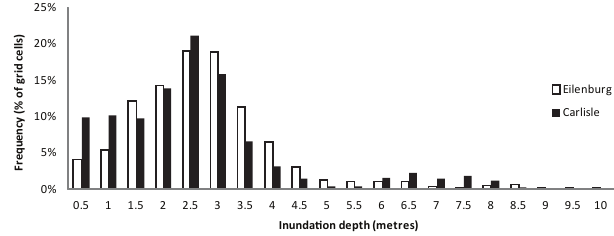
Fig. 5. Histogram of the validated inundation depth simulations for the Eilenburg and Carlisle case studies. The histogram provides the percentage of grid cells (y-axis) inundated with a water depth within a specific 50cm interval